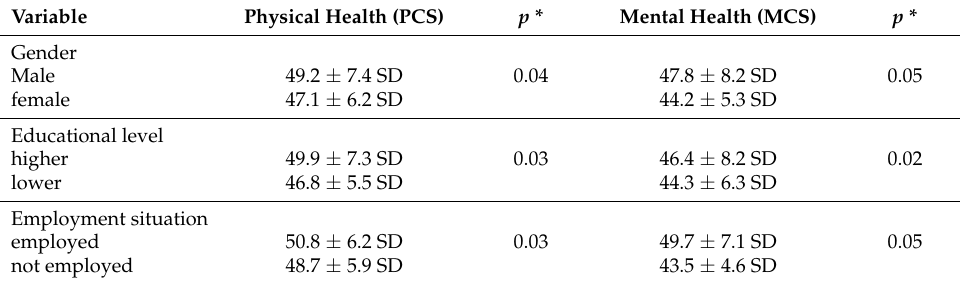
Table 2. Bivariate analysis processing of PCS and MCS.